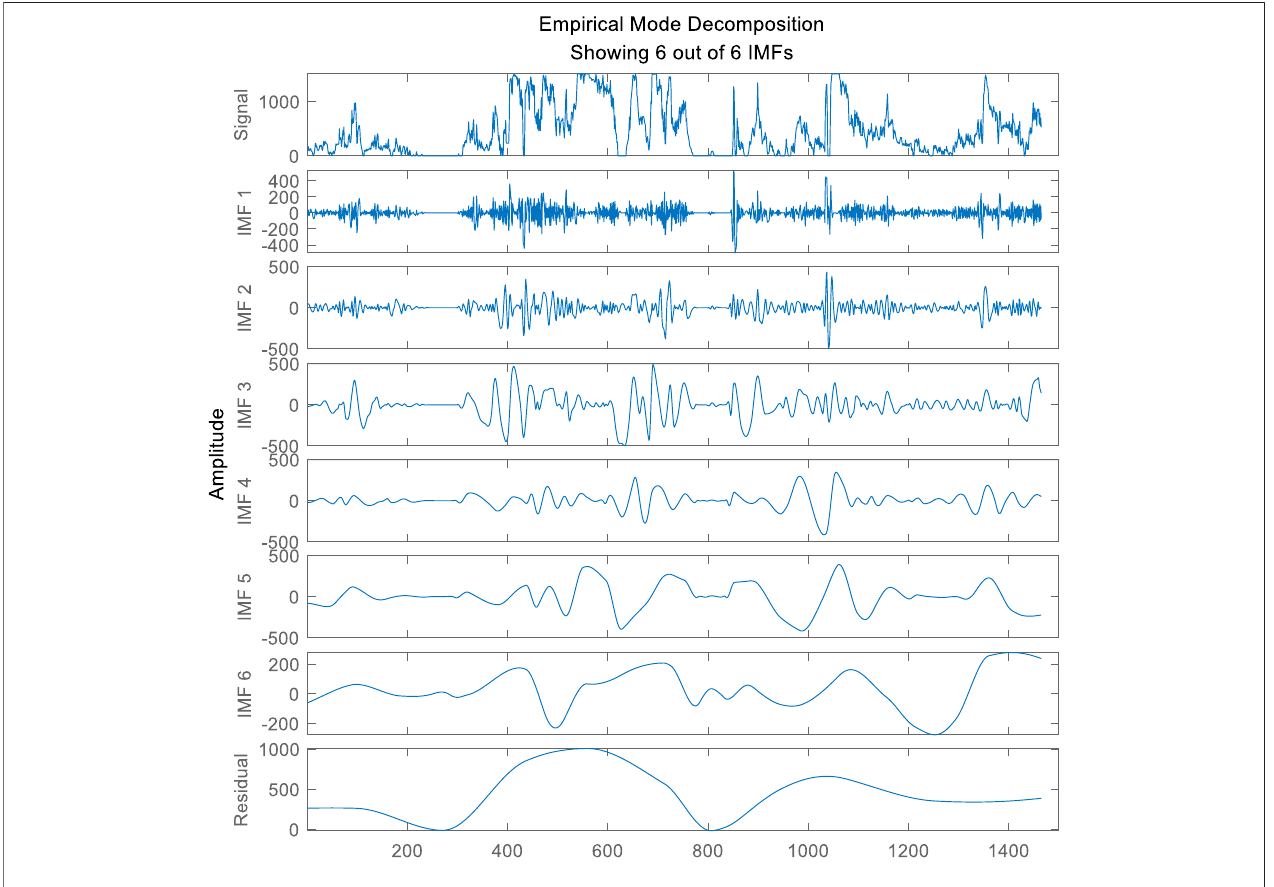
FIGURE 2 | EMD decomposition results of the wind power